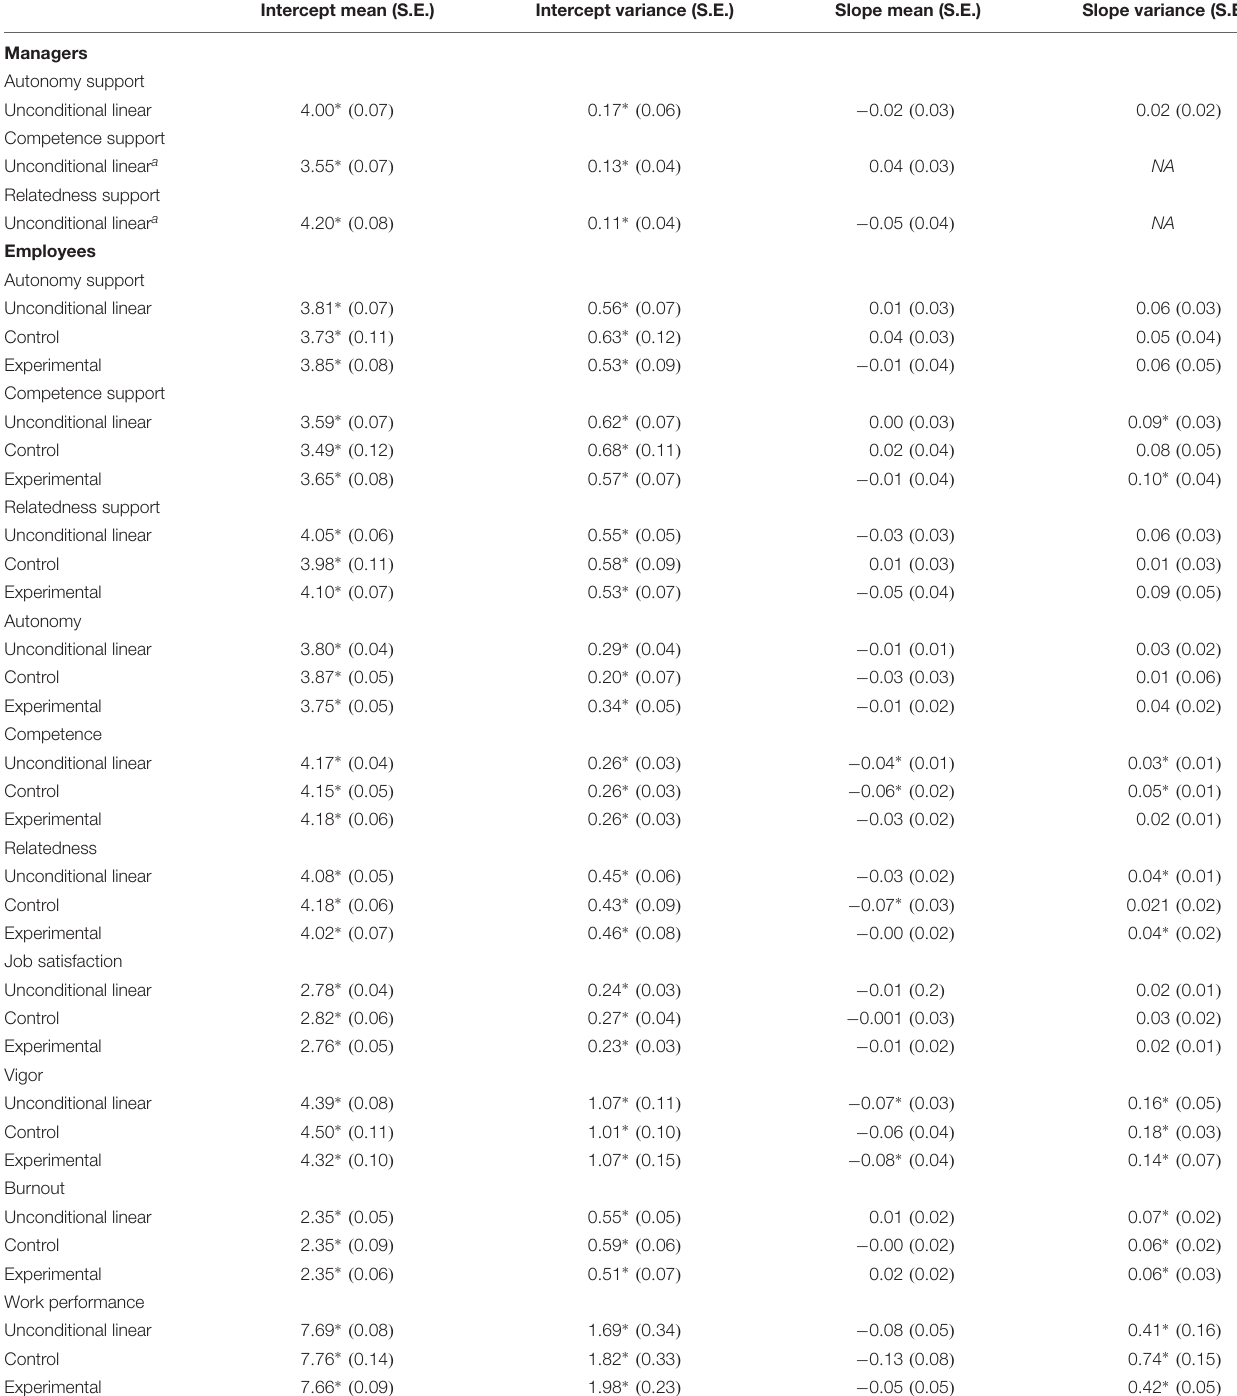
TABLE 3 | Parameter estimates of the LGCA. Intercept mean (S.E.) Intercept variance (S.E.) Slope mean (S.E.) Slope variance